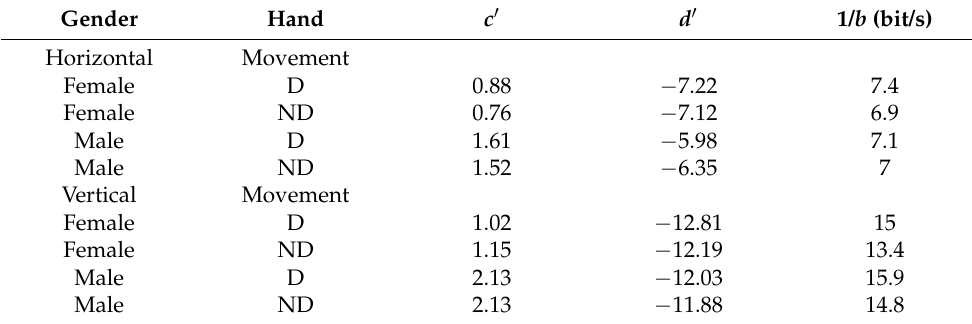
Table 4. Coefficients of ID adj and 1/ b